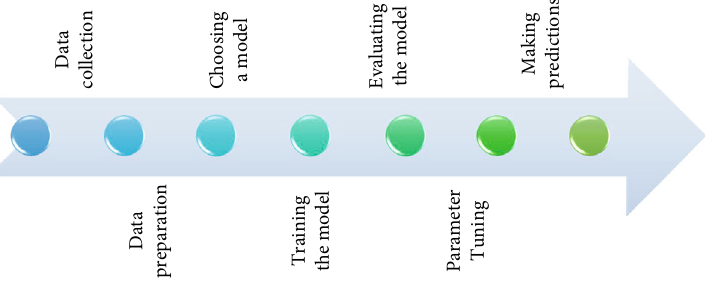
Figure 2: Block diagram of the basic machine learning stages.